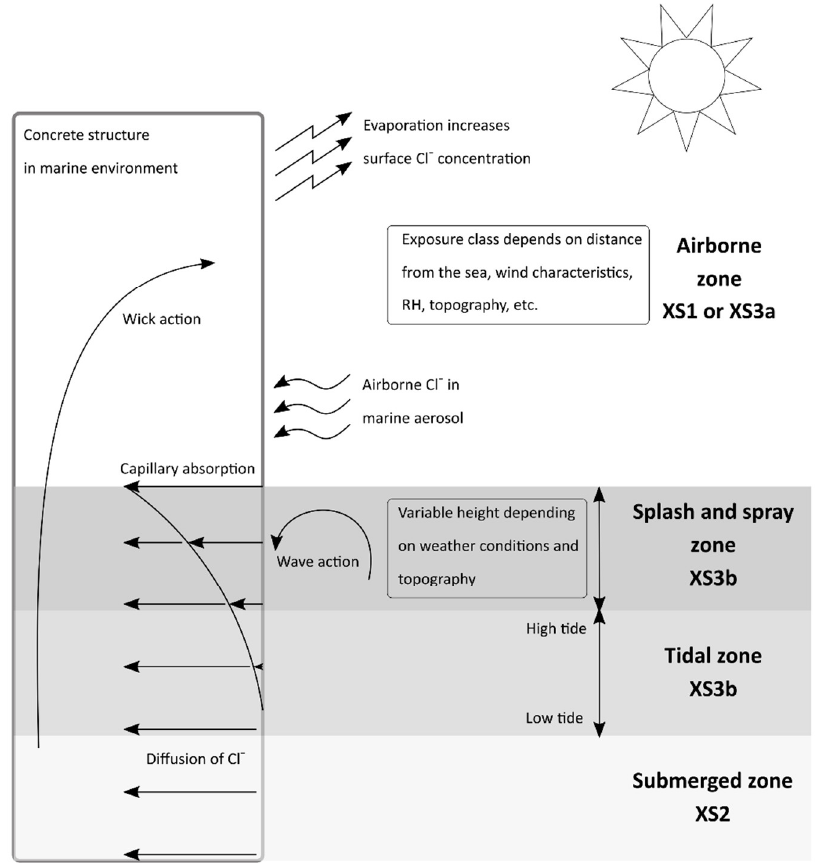
Figure 2. Marine exposure environment classification and corresponding transport mechanisms for concrete structures (extracted from Beushausen et al. [7]).